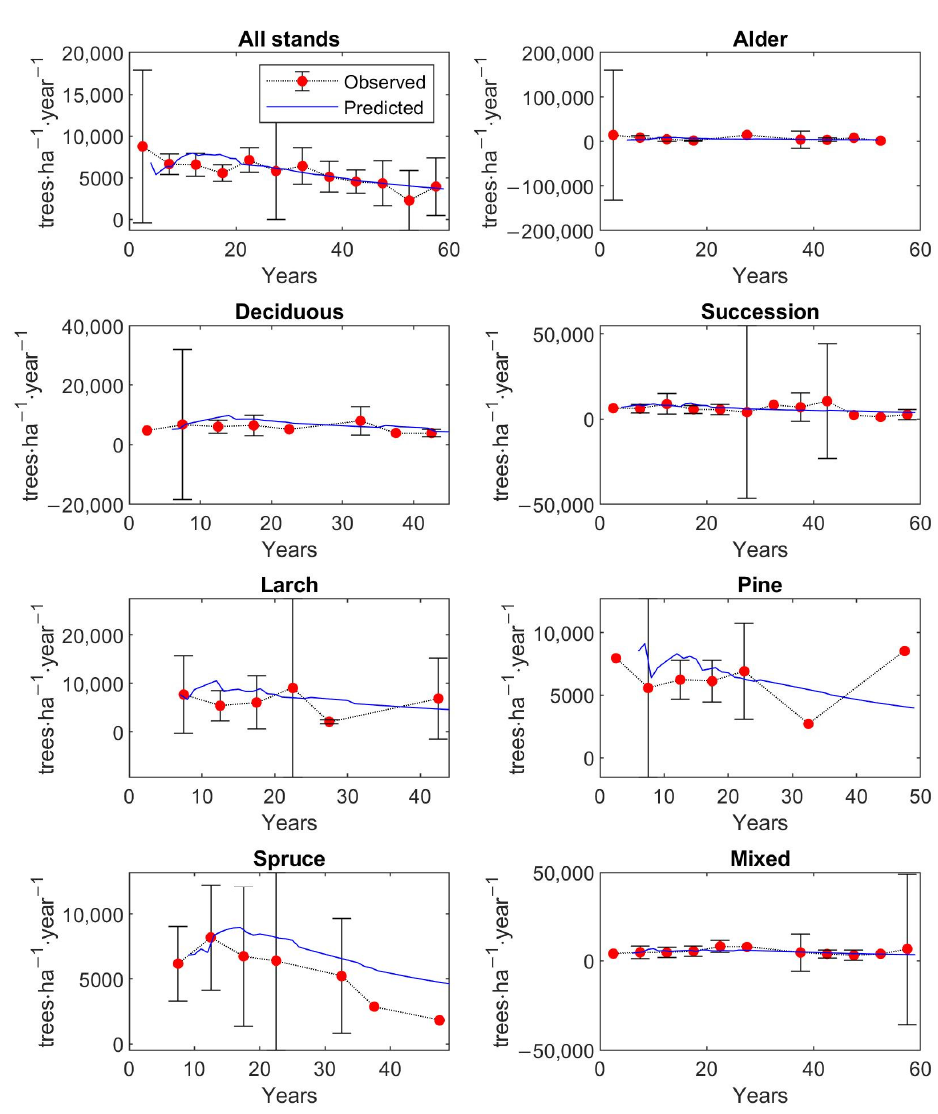
Figure A3. Verification of the model by the comparison of the observed 5-year average values with average predicted values of stem density, with a 95% confidence interval, according to individual forest types.